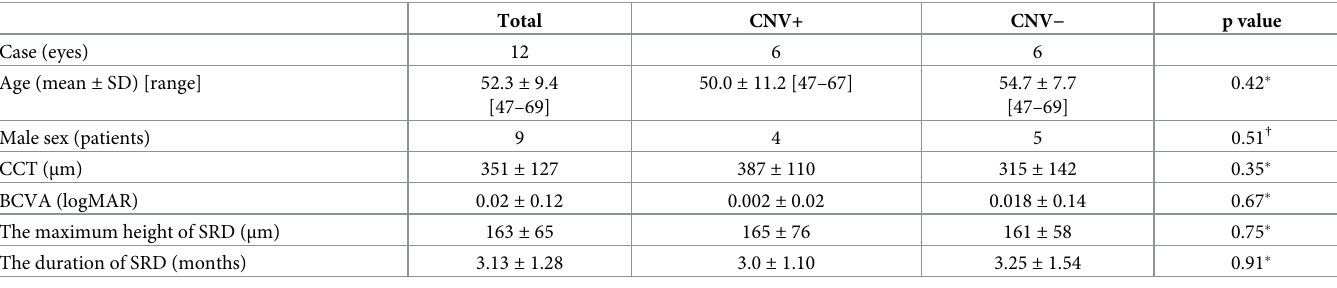
Table 1. Demographic characteristics of the